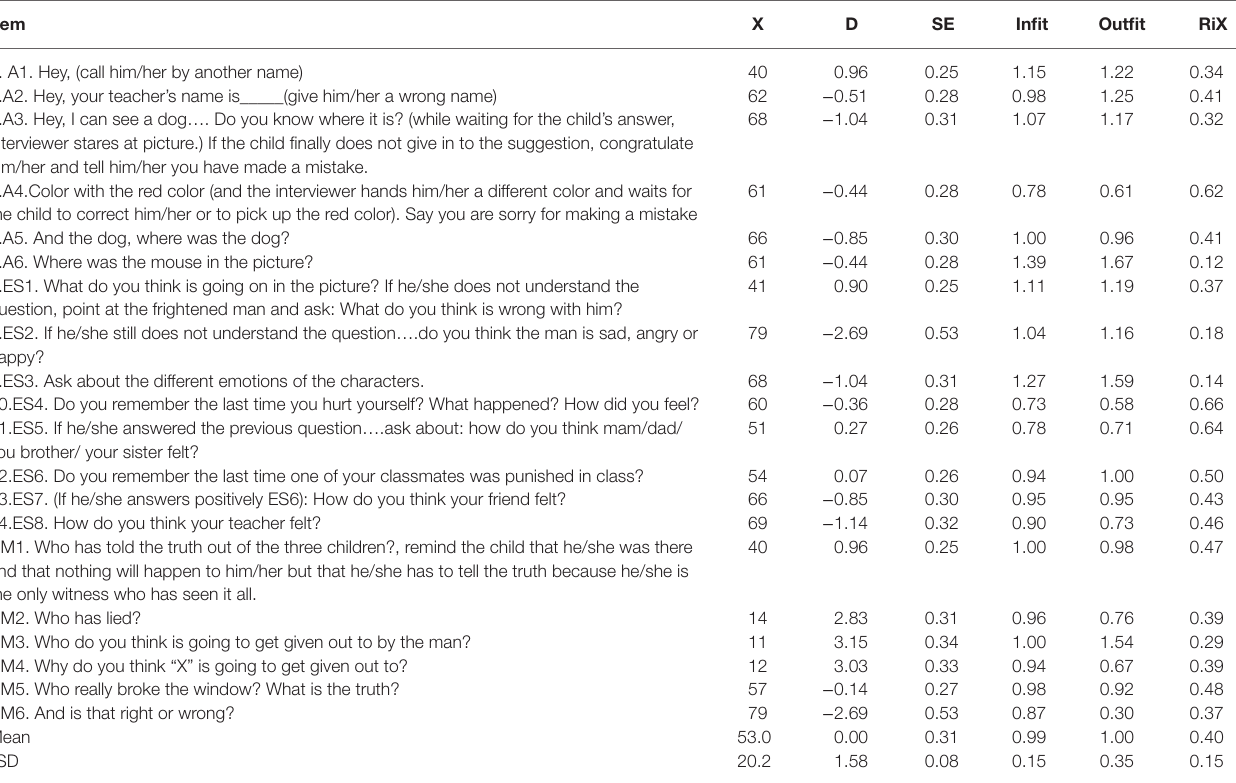
TABLE 6 | CAPALIST- social thinking. Item properties. Item